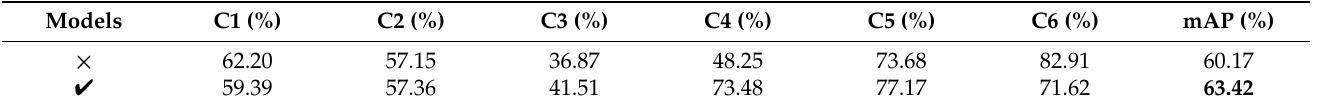
Table 7. Effectiveness of TDM.